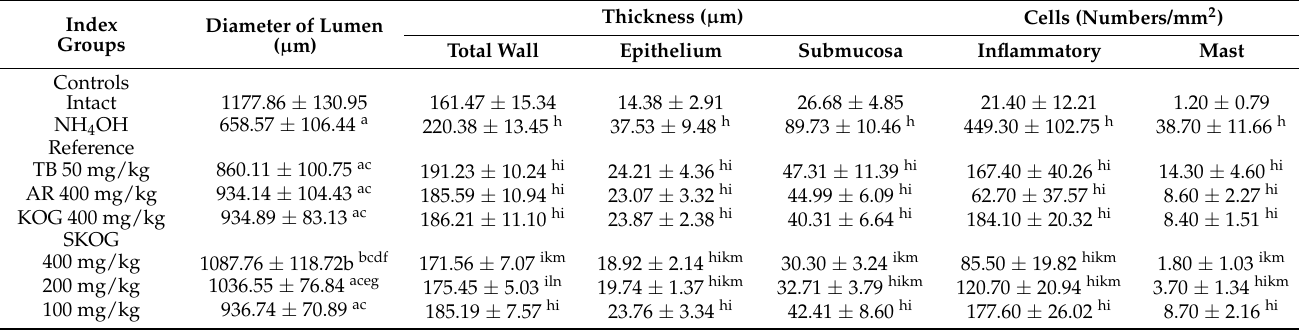
Table 1. Effects of AR, KOG, and SKOG on the histomorphometry of trachea in mice.